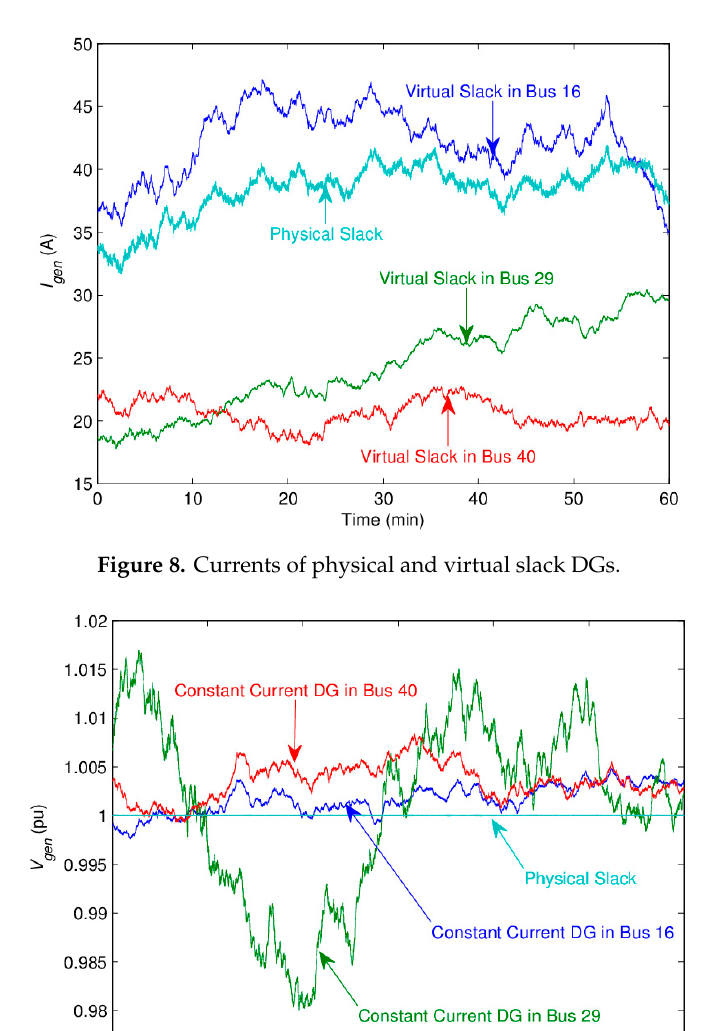
Figure 7. Voltages of physical and virtual slack distributed generations (DGs).